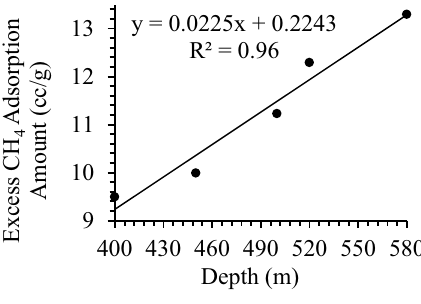
Fig. 5 Variation of excess CH